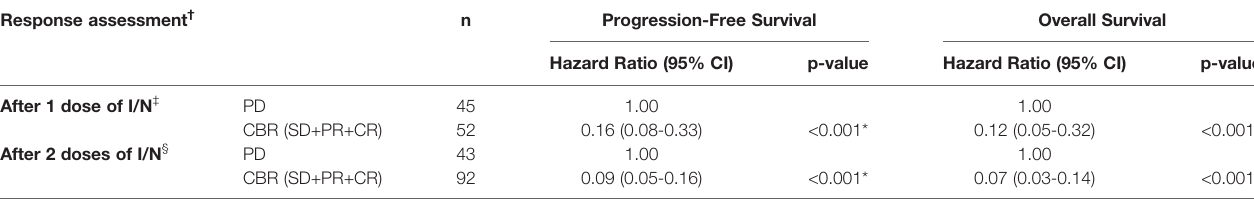
TABLE 4 | Cox proportional regression model for progression-free survival and overall survival following initial response assessment (PD as the reference group). Response assessment